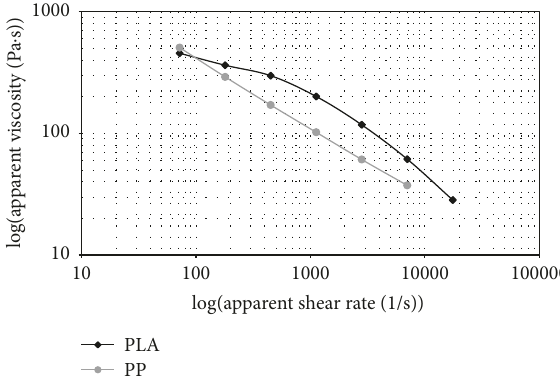
Figure 3: log-log plot of the apparent viscosity as a function of the apparent shear rate of neat PLA and